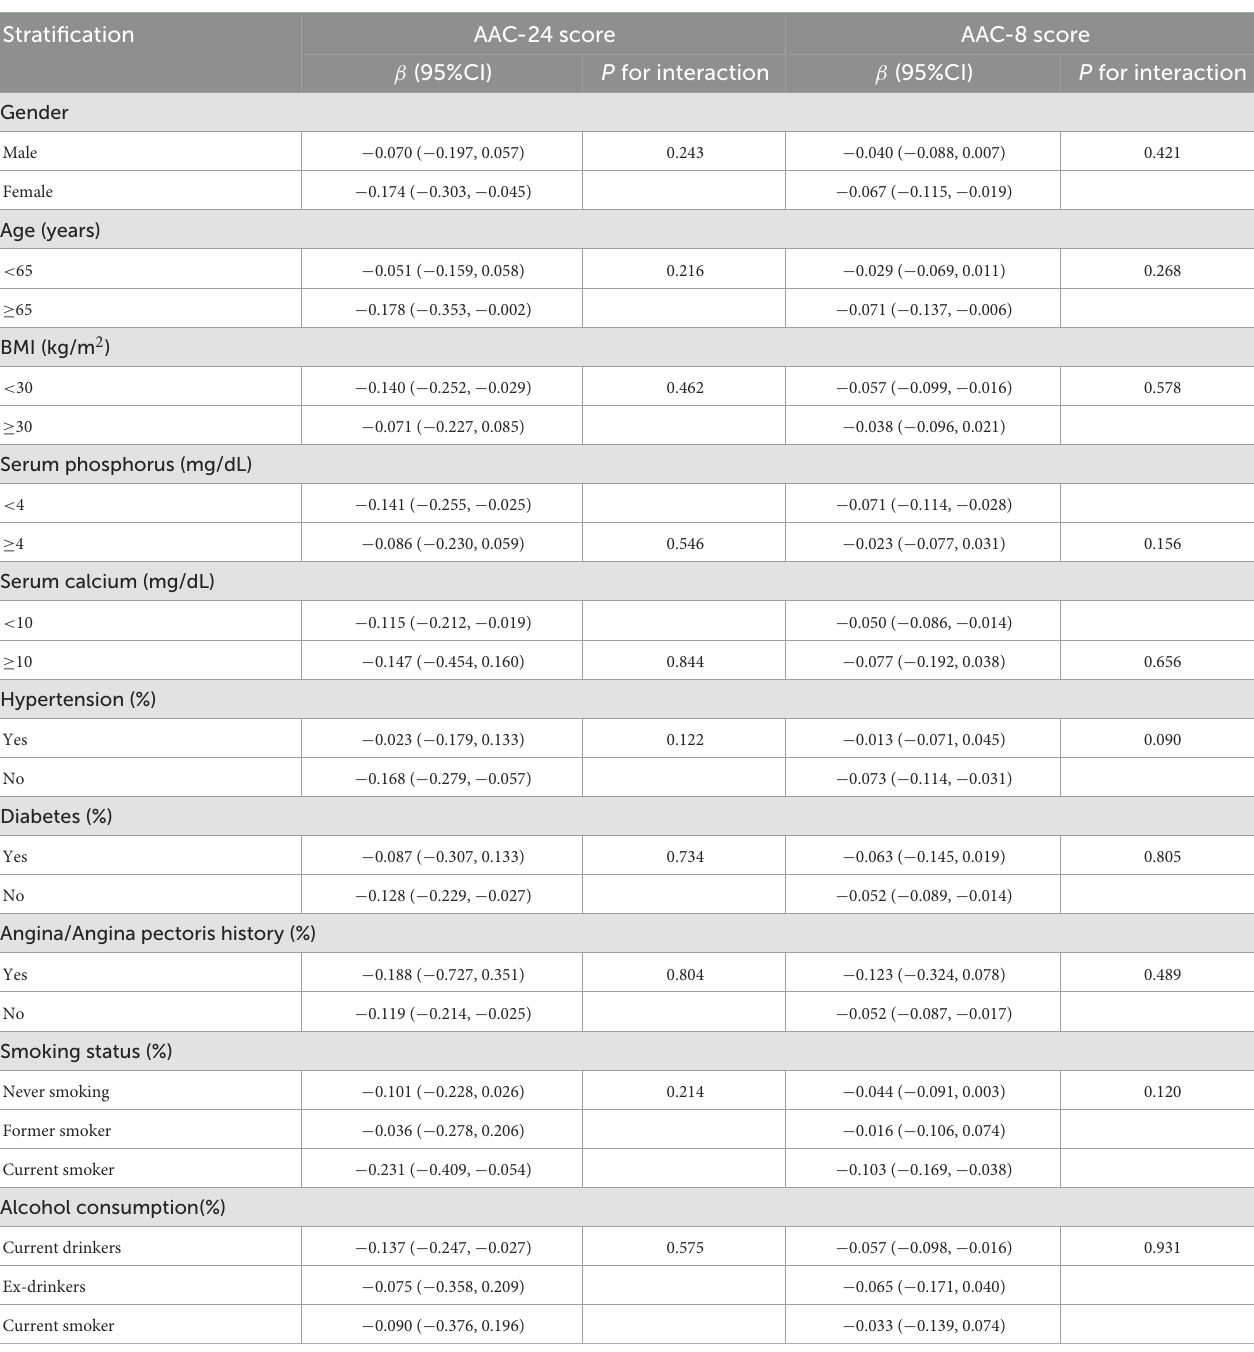
TABLE 4 Subgroup